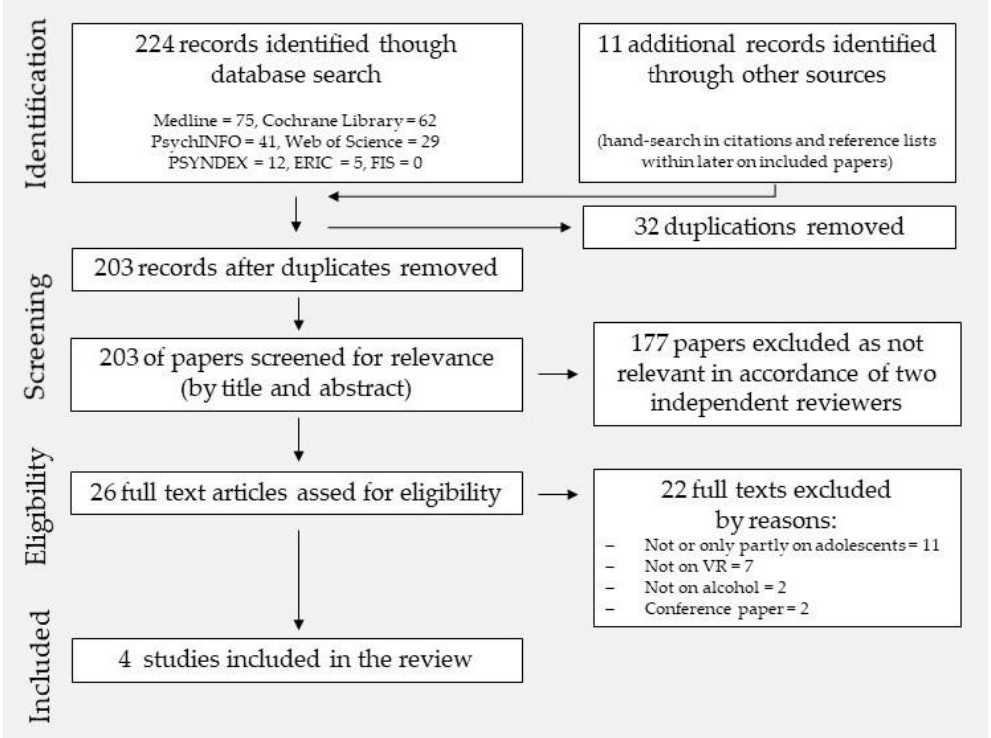
Figure 1. PRISMA flow diagram for the procedure of the systematic review.